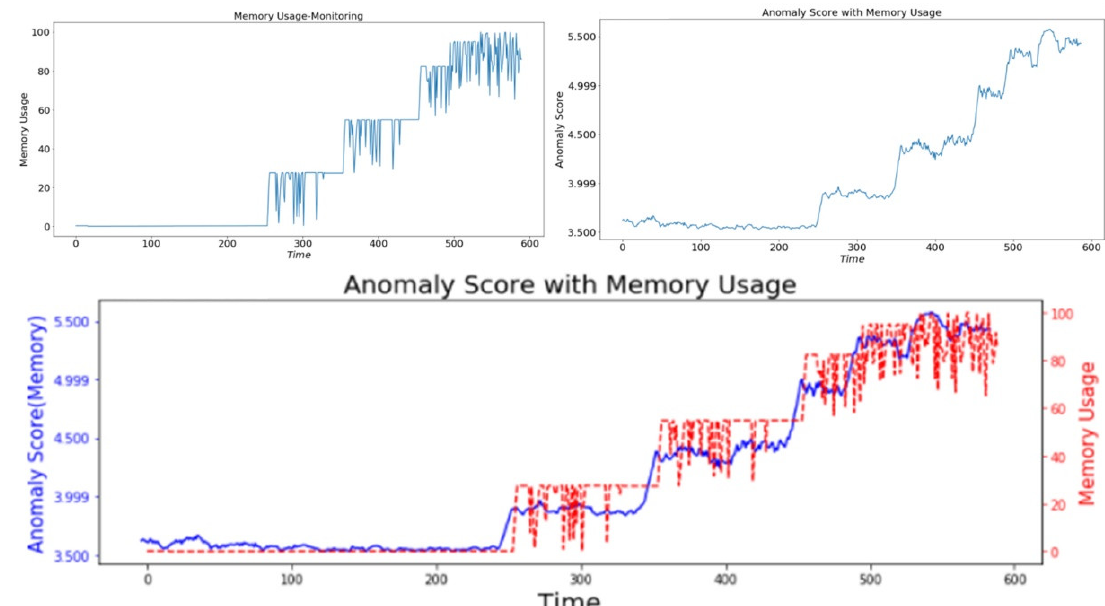
Figure 9. Anomaly Score (Memory Fault-Accumulative).